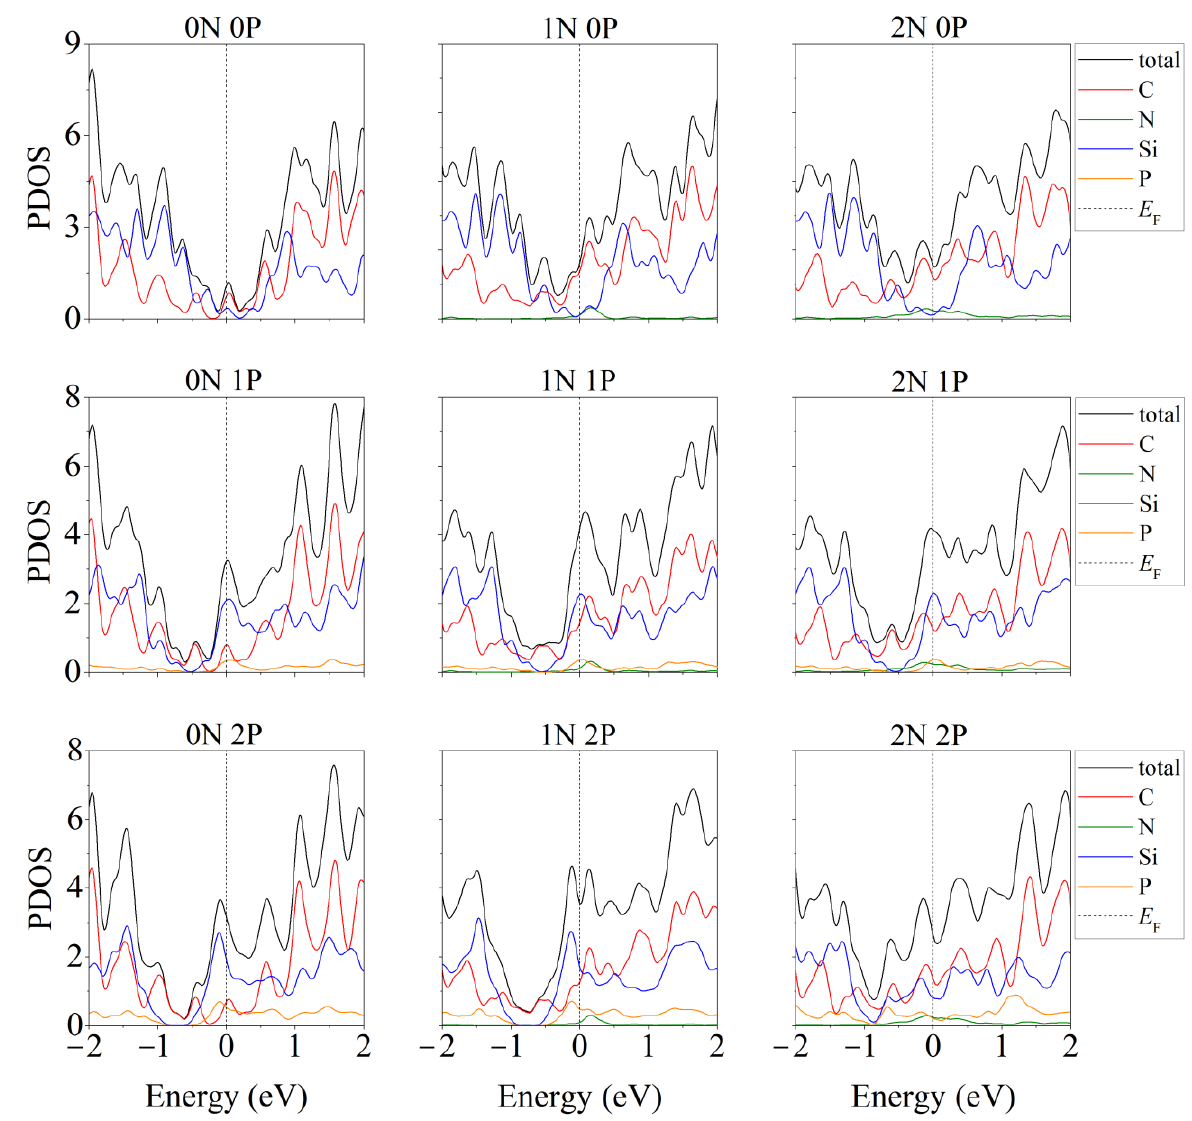
Figure 5. Partial densities of electronic states of doped systems “two-layer silicene/graphite substrate” at various degrees of doping with P and N. Reprinted with permission from Ref. [46]. 2020, Springer.